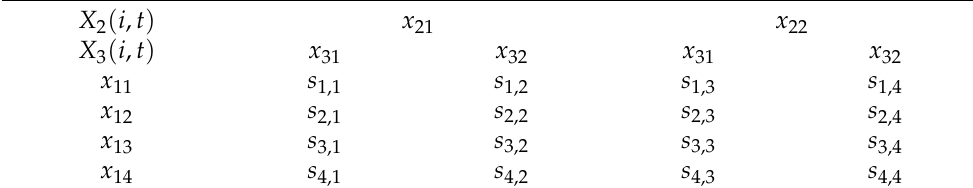
Table 4. CPD of X 1 ( i , t + ∆ t ) .